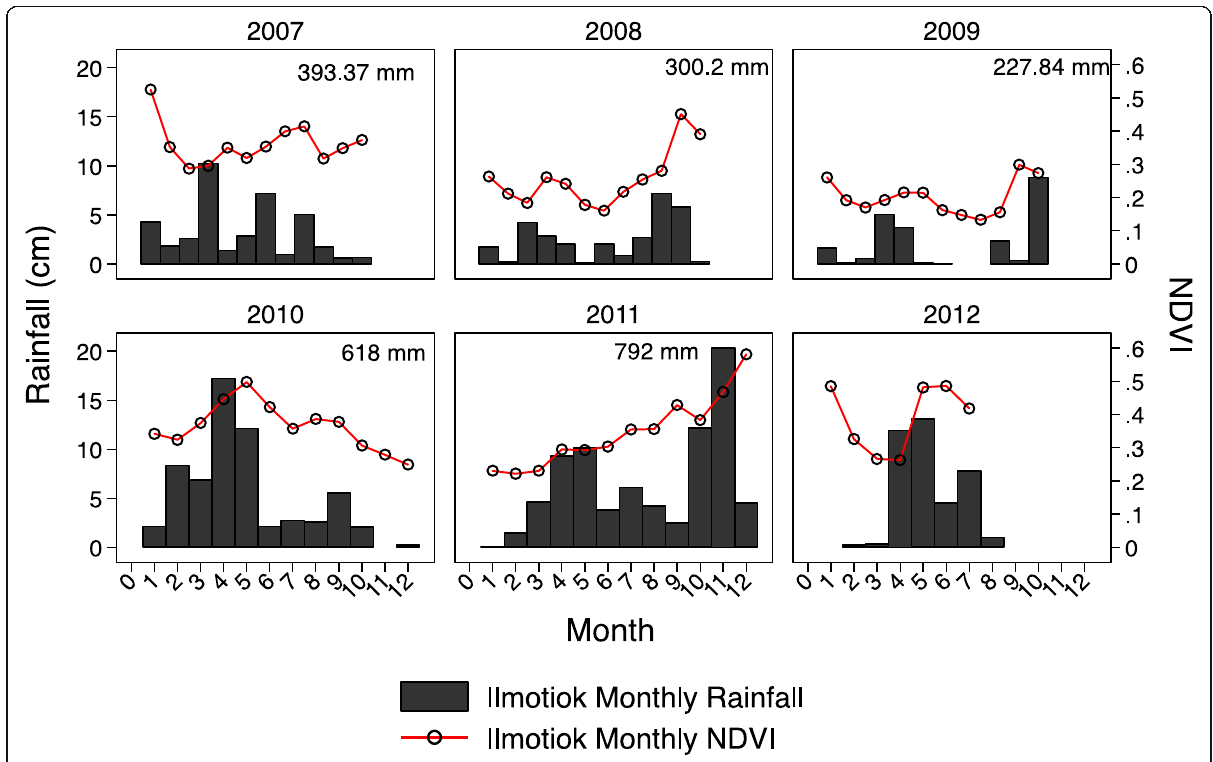
Figure 3 Monthly rainfall and NDVI values for the Ilmotiok group ranch over a five-year period (2007 to 2012). Yearly rainfall values for each year are superimposed on the graph in the upper right-hand corner of each quadrant of the graph. The red connected line indicates NDVI whereas the black bars indicate average rainfall